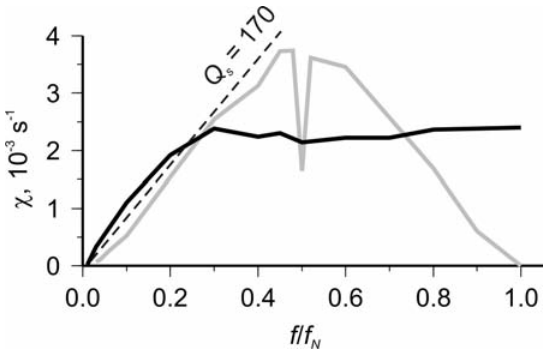
Figure 10. Frequency dependence of attenuation coefficient | in 1D propagation. Gray, propagation in a sequence of layers with equal travel times; black, propagation in layers with travel-times distributed according to a log-normal distribution. Dashed line, level of «scattering Q» equal to